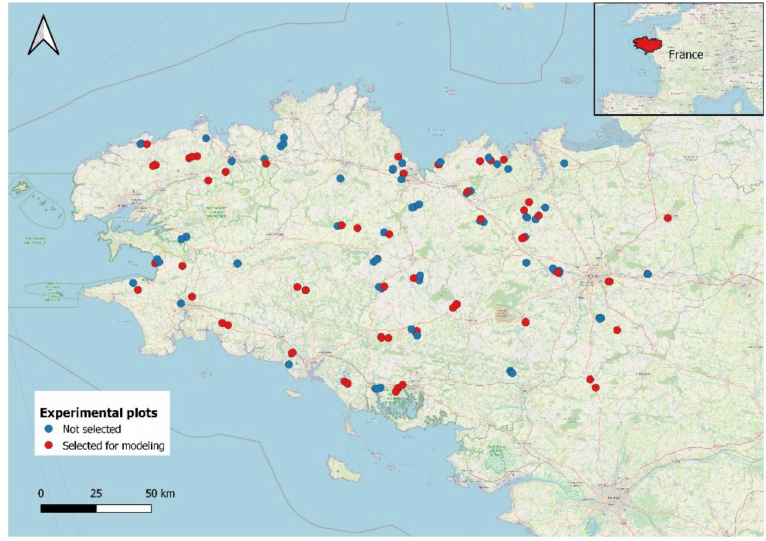
Figure 1. Locations of experimental fields in the network in Brittany, France (red points indicate the 67 fields